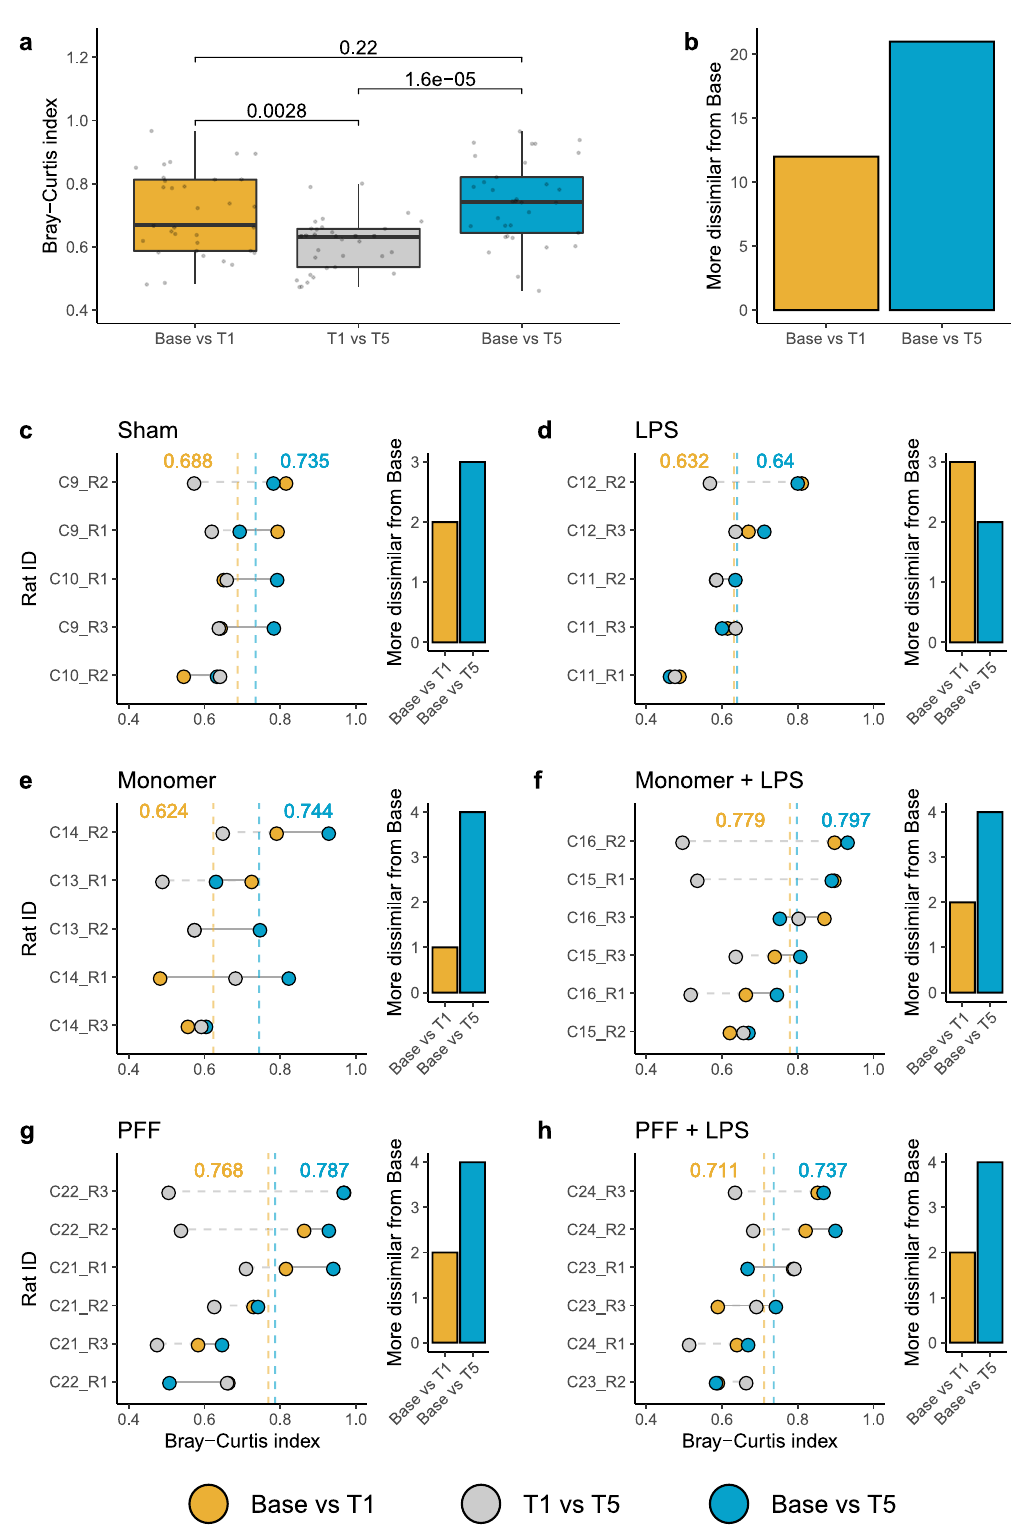
Fig. 4 Changes in the faecal virome of individual rats, separated by the treatment conditions. a The Bray – Curtis dissimilarity index values for all rat faecal viromes between study time points, with Wilcoxon test p values shown. Points represent the speci fi c Bray – Curtis index values. b Summary of whether faecal viromes analysed were more dissimilar from the study ’ s baseline (Base) using the Bray – Curtis index after 1 month (T1) or 5 months (T5). The left-hand image of treatment panels ( c – h ) demonstrates the Bray – Curtis dissimilarity for individual rat faecal viromes. A horizontal solid grey line connects the ‘ Base versus T1 ’ and ‘ Base versus T5 ’ Bray – Curtis values, while a horizontal dashed grey line indicates the Bray – Curtis change between T1 and T5. Vertical dashed lines and numerical insets are colour coded to indicate the average Bray – Curtis index values at the respective time points. The right- hand image of each treatment panel speci fi es if T1 or T5 Bray – Curtis values are more dissimilar from the